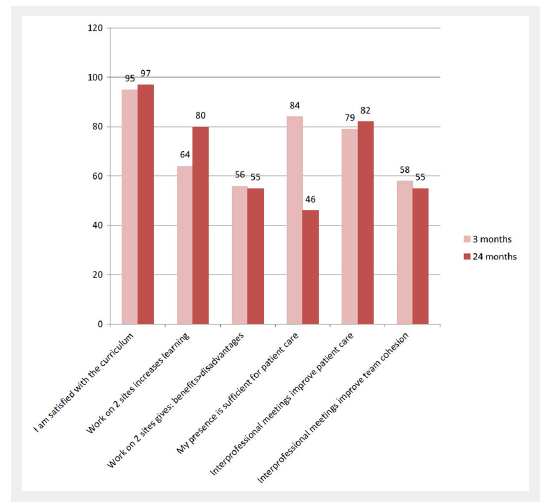
Residents’ satisfaction with the new curriculum at 3 (T3) and 24 (T24) months (expressed in